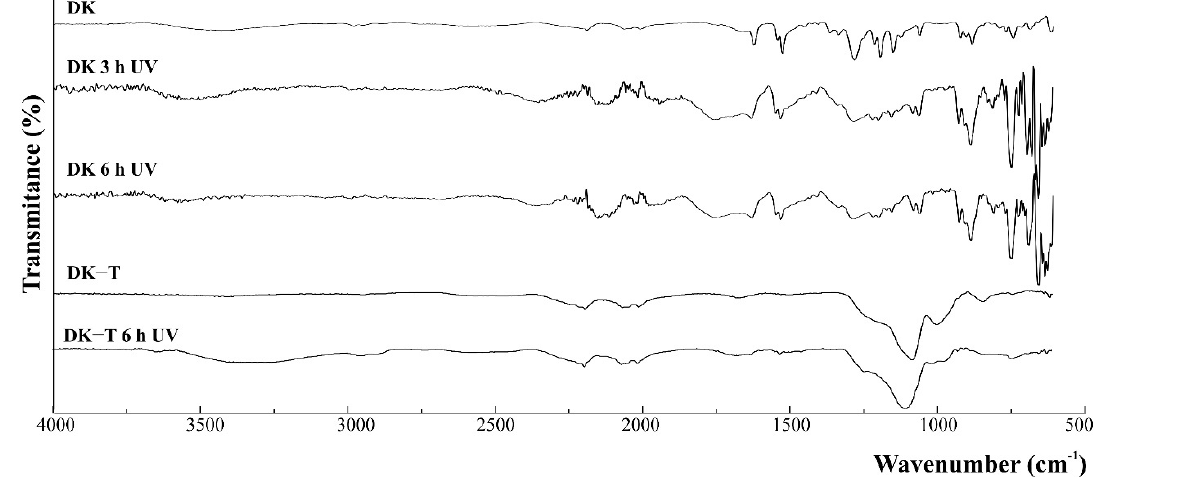
Figure 4. ( A – F ) SEM images for DK and DK-T (DK modified with TiO 2 ) membranes before and after UV exposure (magnification ×3000), ( G ) DK-T EDS, ( H ) EDS mapping showing the Ti distribution on the membrane surface after 6 h UV exposure, and ( I ) Fourier transform infrared spectroscopy (FTIR) spectra for DK and DK-T membranes before and after 3 and 6 h of UV radiation.